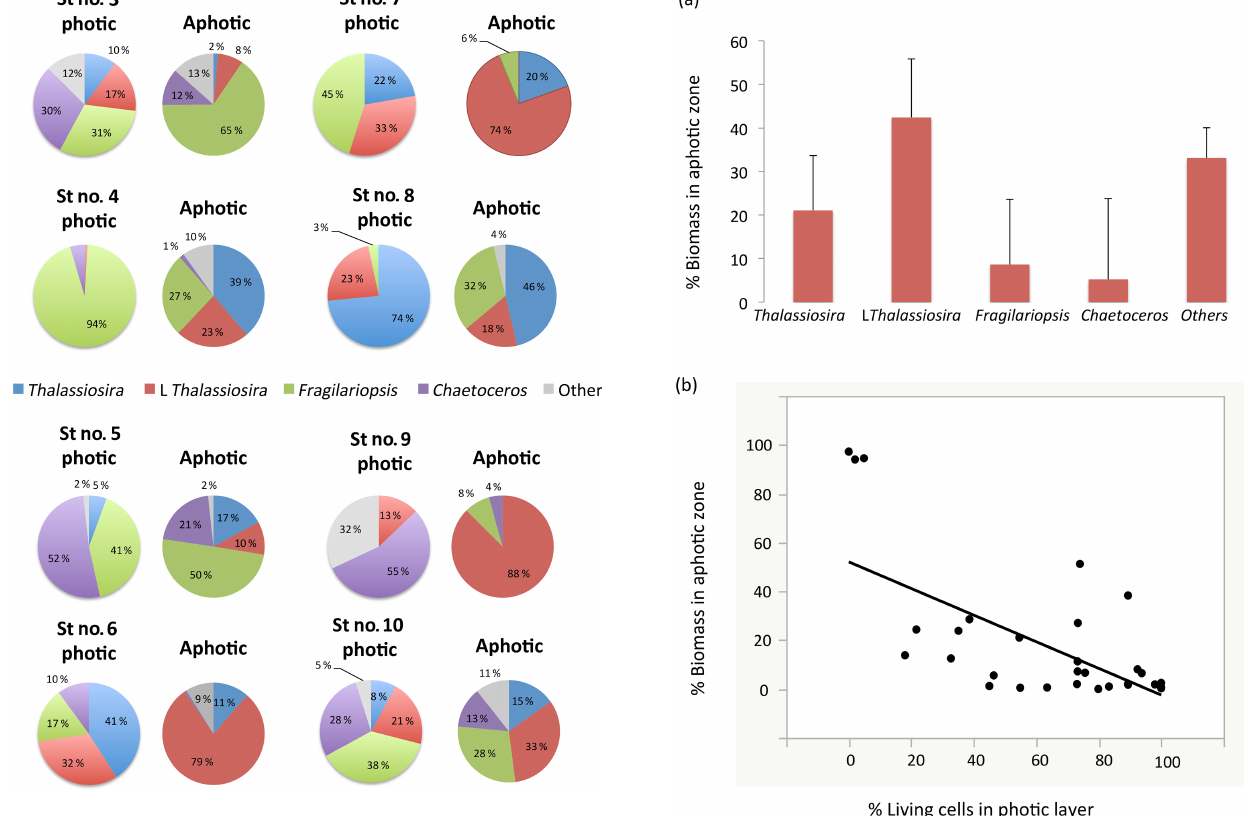
Figure 4. Pie charts showing the diatom community within the photic and aphotic zones among stations. Colors correspond to dif- ferent taxa, and the numbers indicate the percentage of cells relative to the total community.